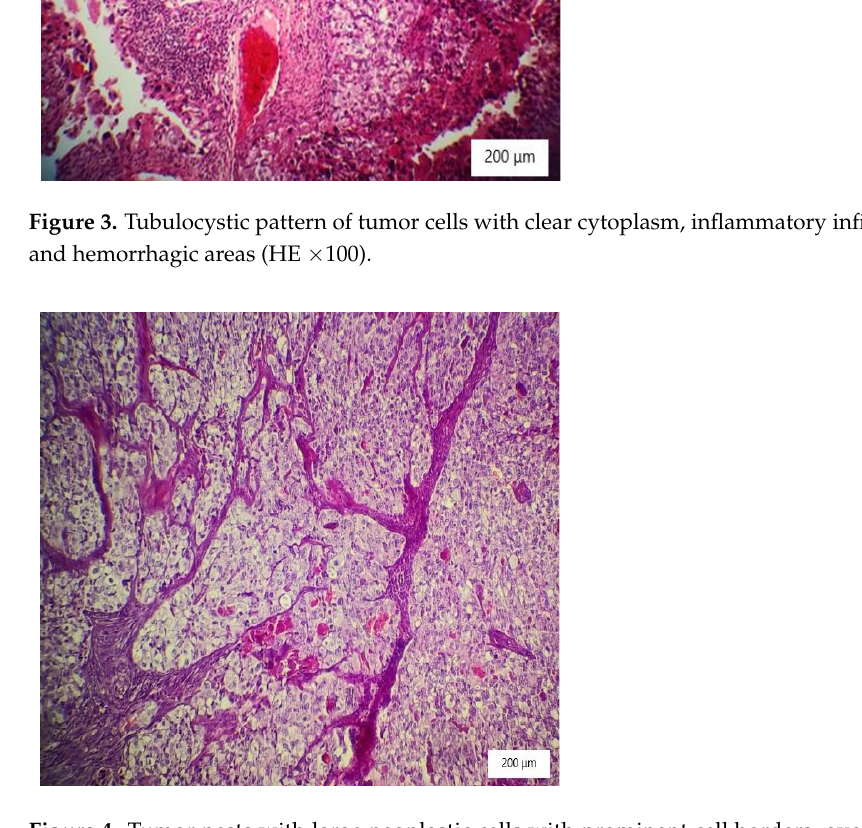
Figure 4. Tumor nests with large neoplastic cells with prominent cell borders, ovoid nuclei, clear cytoplasm, and stromal hyalinization (HE ×100).